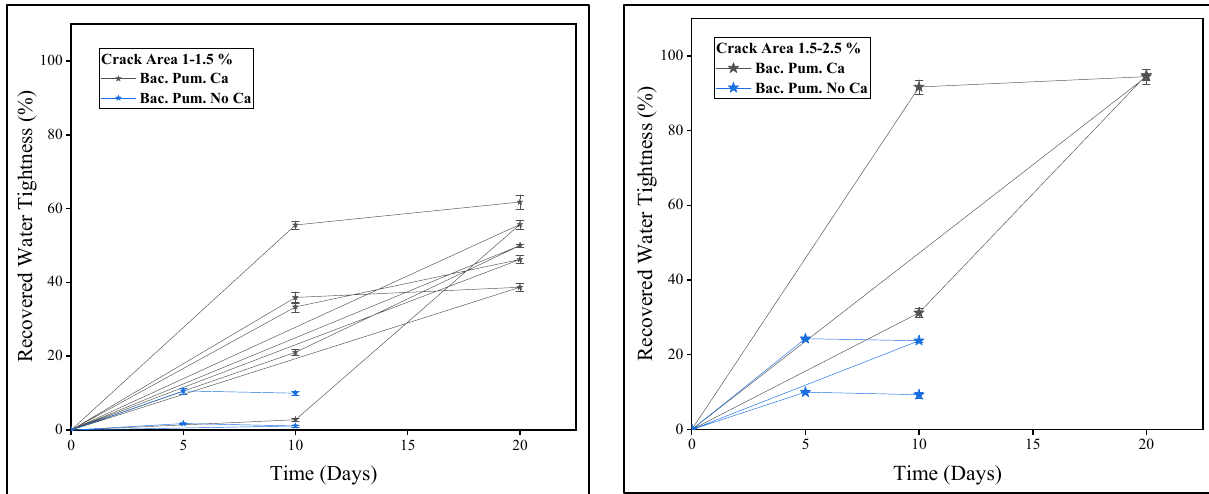
Figure 12. Recovered watertightness using biodeposition treatments.